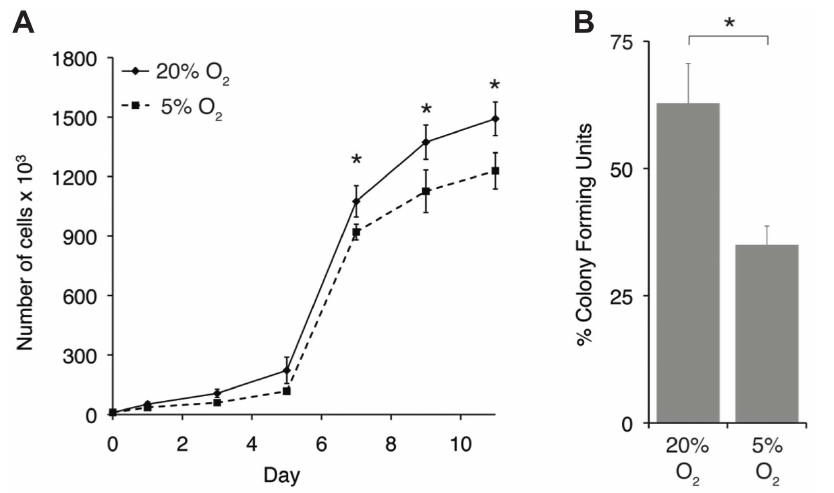
Figure 1. Proliferation and clonogenesis of cells in monolayer. (A) Cells proliferated faster in normoxia than hypoxia. Cell number was greater in normoxia at days 7 ( p =0.04), 9 ( p =0.04), and 11 ( p =0.002). (B) CFU-F was greater in normoxia than hypoxia ( p , 0.0001). Data are mean 6 S.D.